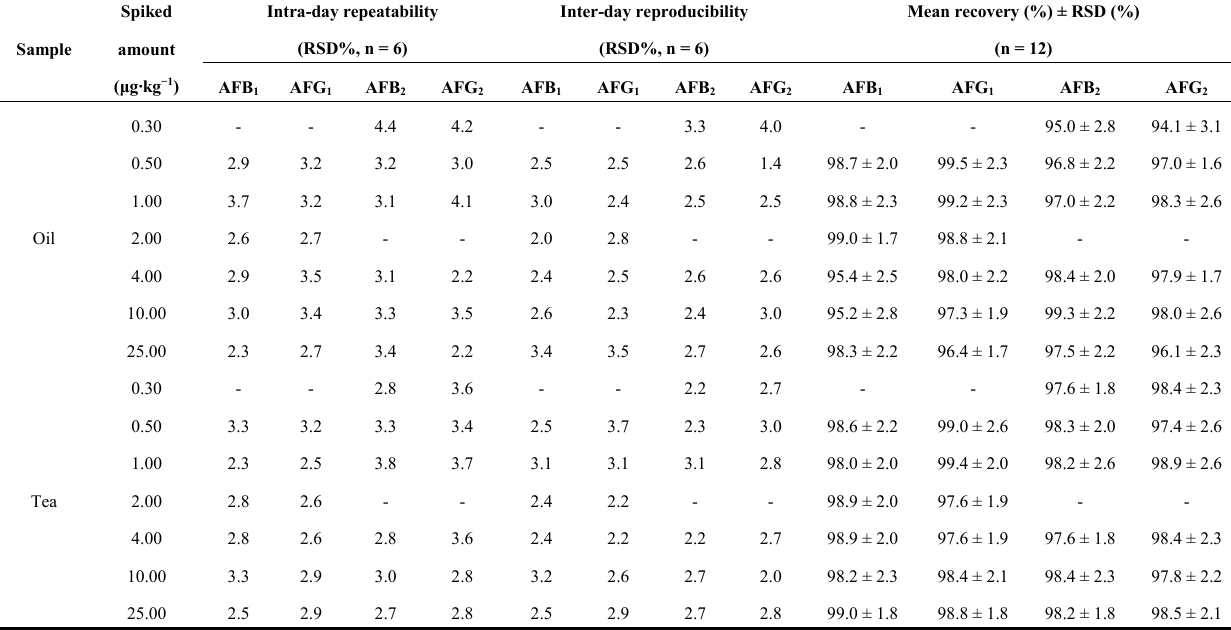
Table 3. Results for aflatoxins in the precision and recoveries study for oil and tea samples. Spiked Sample